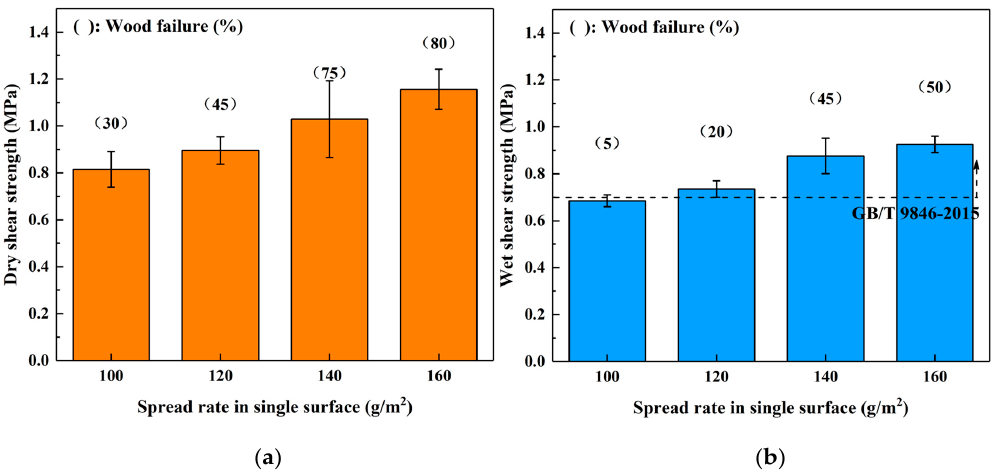
Figure 5. Effects of spread rate in single surface on the bond performance of plywood: ( a ) dry shear strength and ( b ) wet shear strength.